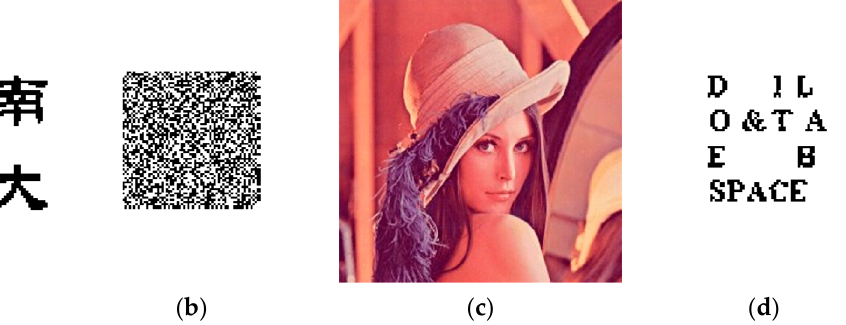
Figure 11. Simulation results of replacing robust watermark ( a ) the watermark image owned by the attacker; ( b ) Self-produced ciphertext watermark image by the attacker; ( c ) the double watermark image with tampered copyright information; ( d ) the fragile watermark image extracted from ( c ).